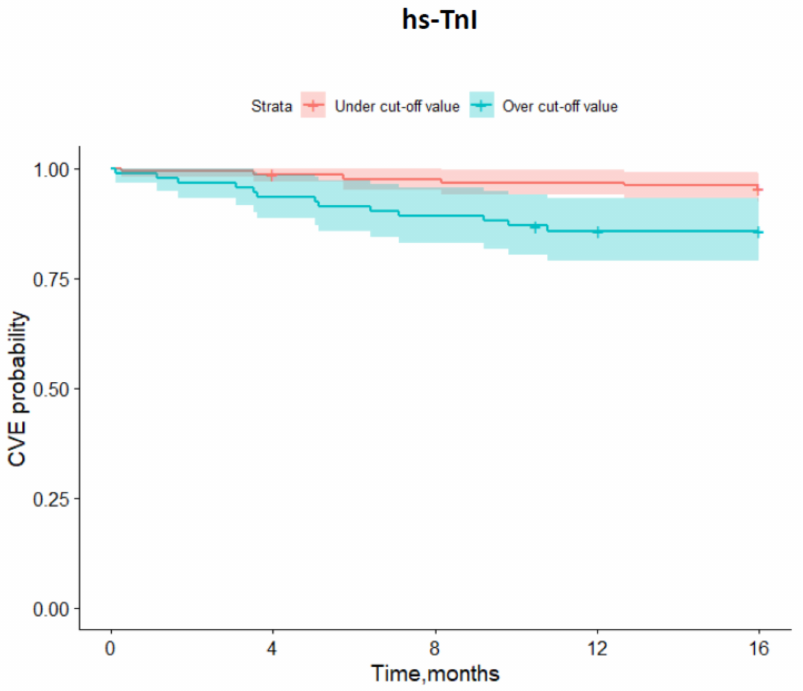
Figure 5. Kaplan–Meier survival curves for major adverse cardiovascular events (MACE) in patients discharged after hospitalization for COVID-19 during follow-up over one year according to under- and over cut-off values for high sensitive troponin I